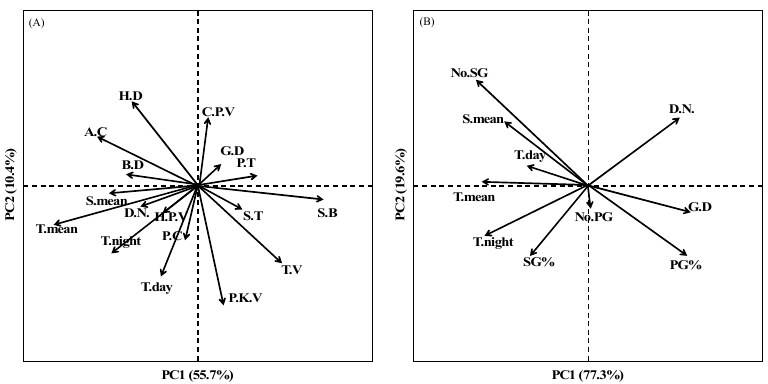
Figure 5. Principal components analysis among after and before heading environmental factors with quality formation related characteristics ( A ) and branching structure ( B ), respectively. Note : H.D represents hardness of rice; S.T represents stickiness of rice; T.V represents taste value of rice; A.C represents amylose content of rice; A.M represents amylopectin content of rice; P.K.V represents peak viscosity of rice; C.P.V represents cold paste viscosity of rice; H.P.V represents hot paste viscosity of rice; S.B represents setback of rice; B.D represents breakdown of rice; P.T represents pasting temperature of rice; S.mean represents average solar radiation of rice; T.mean represents average temperature of rice; T.night represents night temperature of rice; T.day represents day temperature of rice; D.N represents ratio of day and night duration of rice; G.D represents growth duration of rice; No.S represents spikelets number per panicle of rice; No.SG represents number of grains located in secondary branches of rice; No.PG represents number of grains located in primary branches of rice; SG% represents ratio of grains located in secondary branches of rice; PG% represents ratio of grains located in secondary branches of rice.